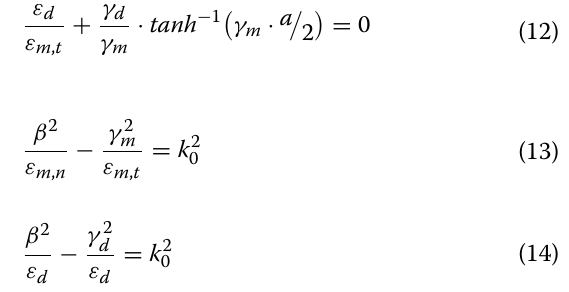
0.1) is sandwiched by silica (Q) or soda-lime glass (G) symmetric cladding. =